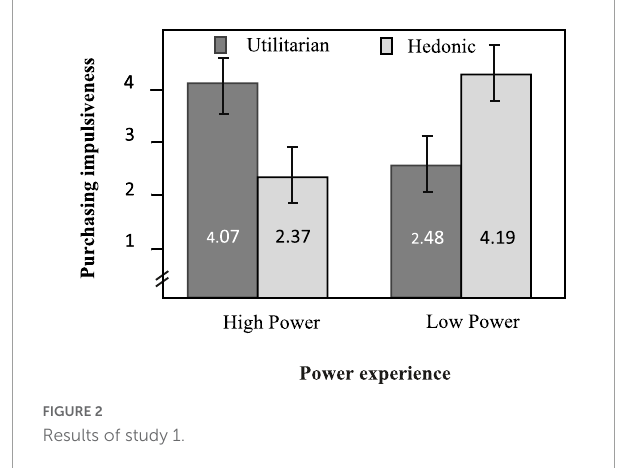
FIGURE2 Results of study